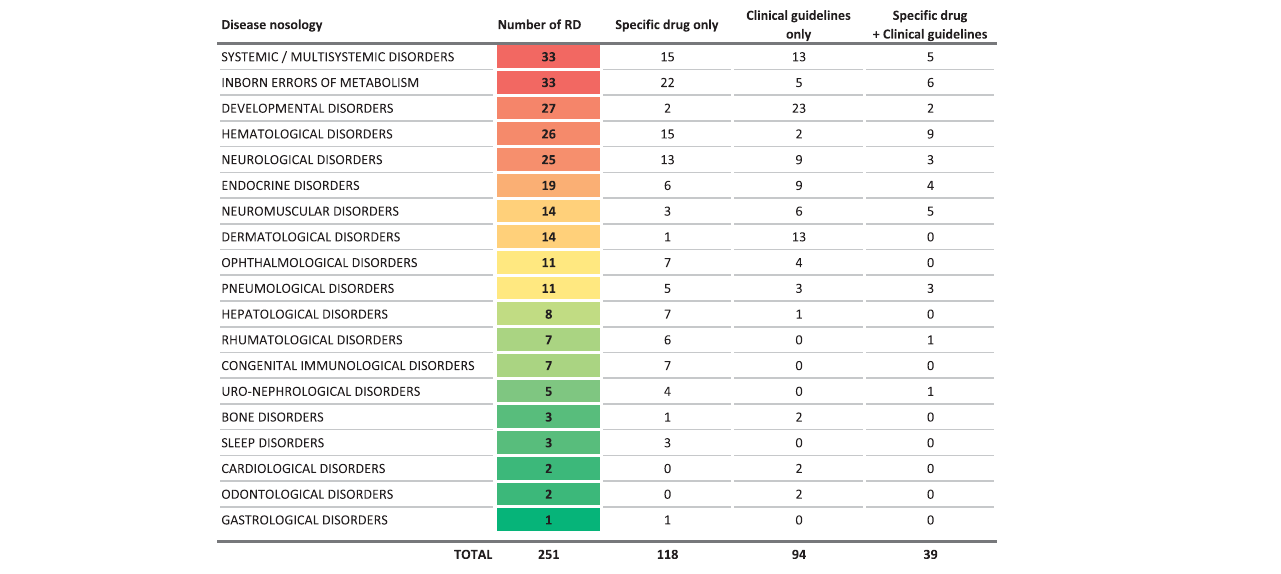
Frontiers in Pharmacology |